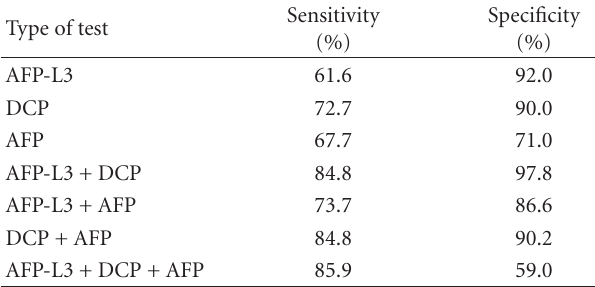
Table 1: Diagnostic values of HCC serum markers